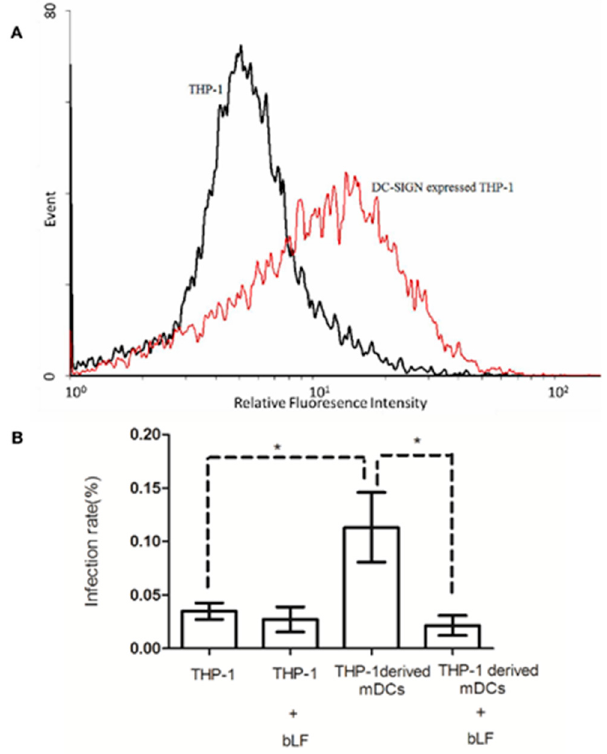
Figure 3. Role of DC-SIGN in the anti-DENV2 activity of bLF. The THP-1 cells were stimulated with recombinant IL-4, GM-CSF, and TNF- α according to a previous report [19], and dendritic cell-specific intercellular adhesion molecule 3-grabbing non-integrin (DC-SIGN) expression was subsequently measured by flow cytometry using mouse anti-human DC-SIGN antibodies and fluorescein isothiocyanate (FITC)-conjugated goat anti-mouse immunoglobulin G (IgG) antibodies ( A ) The DC-SIGN-expressing and non-expessing THP-1 cells were treated with 200 µ g/mL bLF, then infected with DENV-2 at MOI of 5, and analyzed by infectious center assay; ( B ) The infection rate equals 100 × (plaque number/cell number) (* p < 0.05).